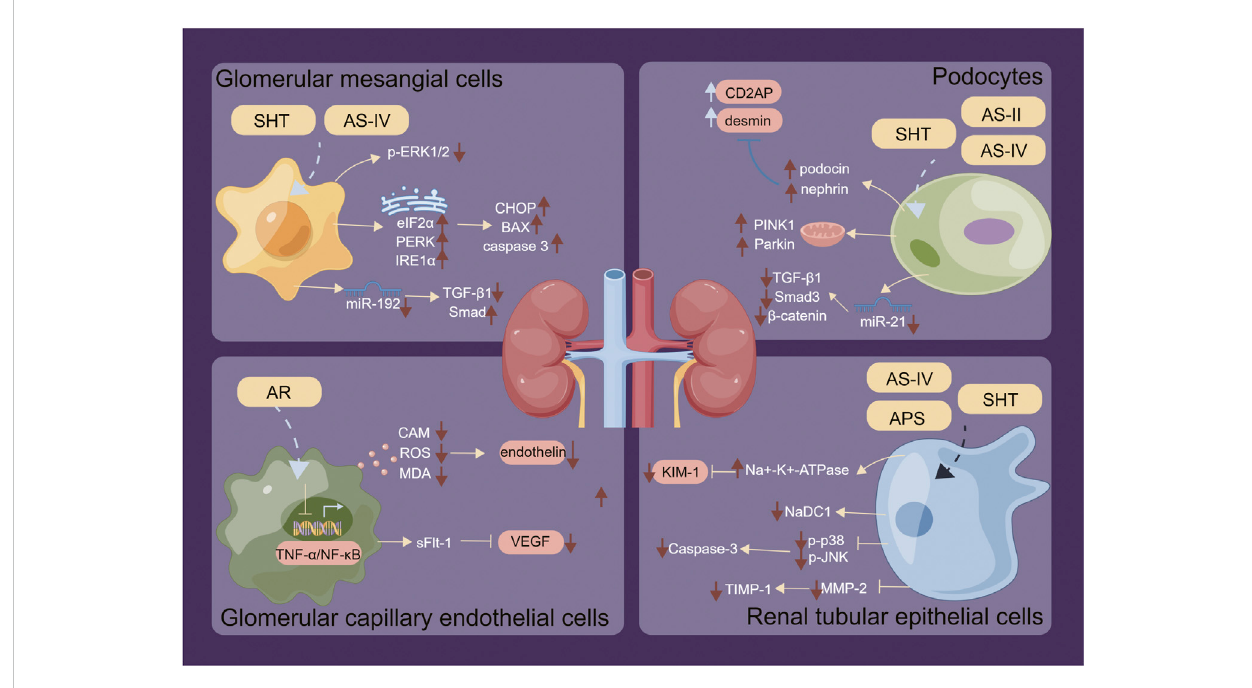
FIGURE 5 Regulatory mechanisms of SHT, AR and AS-IV on renal intrinsic cells. Arrows and lines represent signal activation or inhibition. Note: SHT, Fufang Shenhua tablet; AR, Astragali Radix; AS-IV, Astragaloside IV; APS: Astragalus polysaccharide; AS-II, Astragaloside II. By